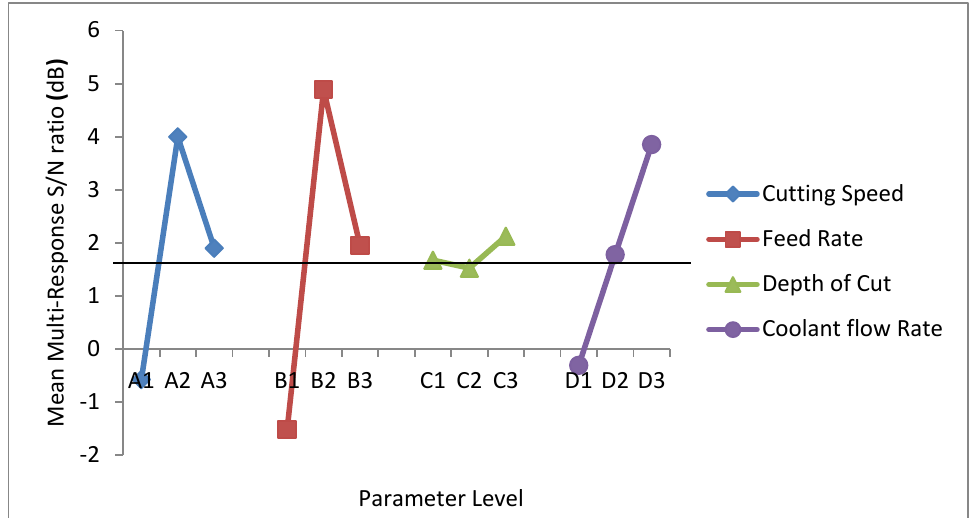
Fig. 3. Response graph of MRSN